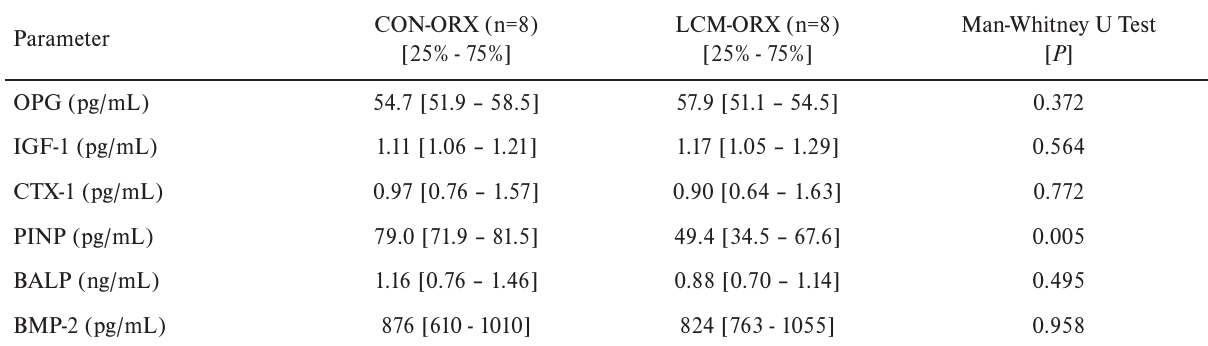
Table 2. Levels of bone